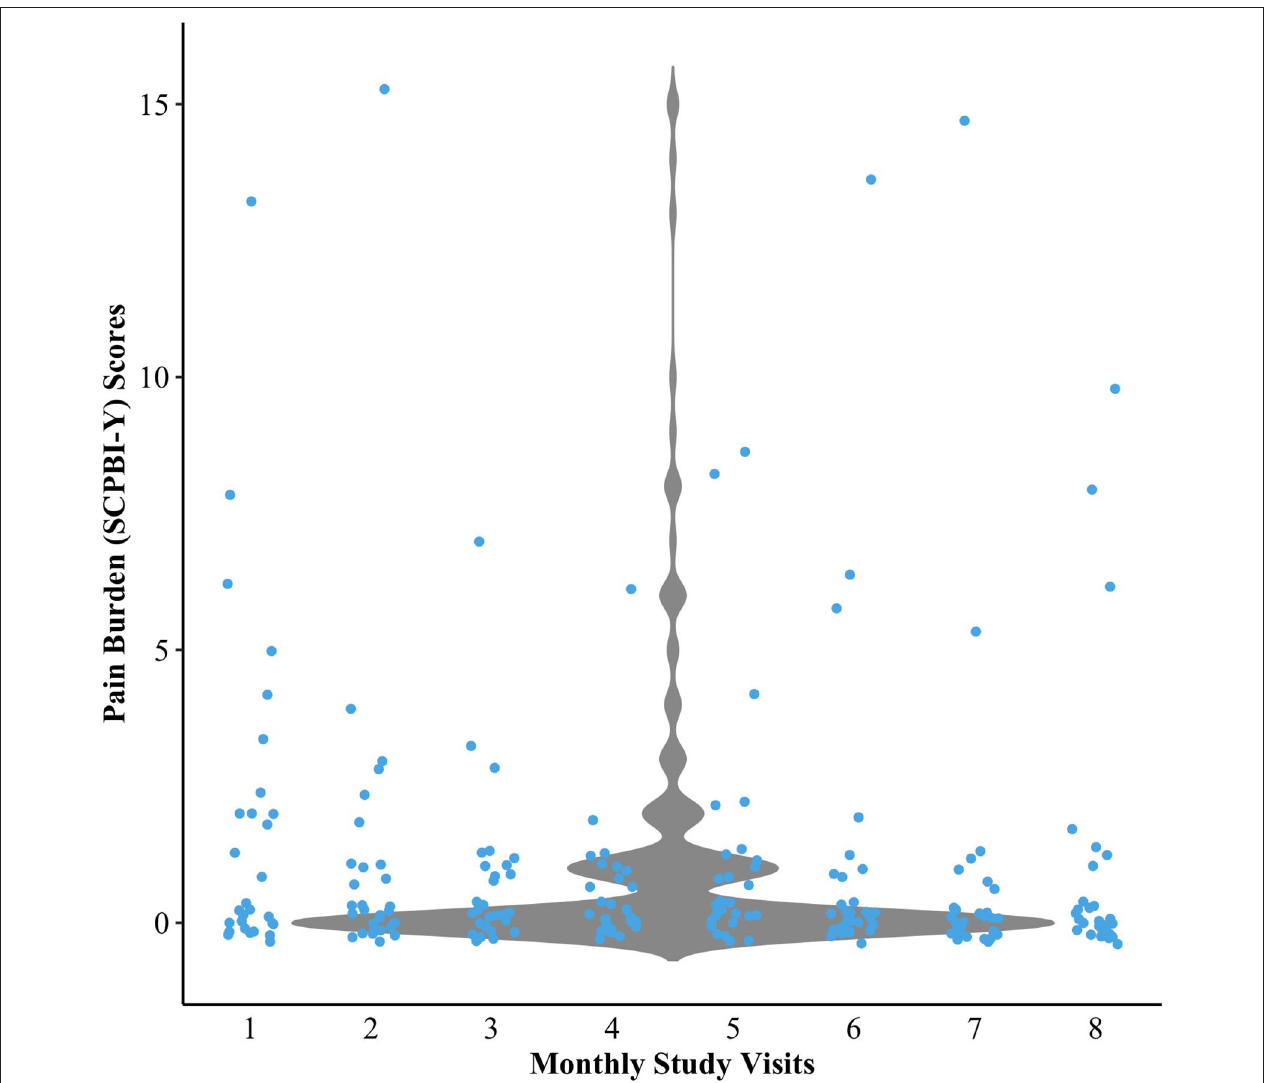
FIGURE 2 | Violin plot demonstrating the variability in pain burden scores over 8 study visits. SCPBI-Y, Sickle Cell Pain Burden